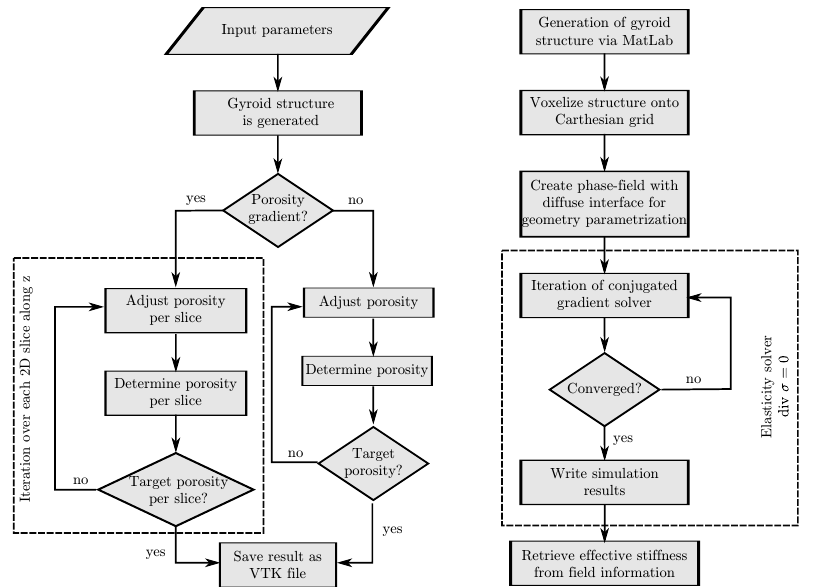
Figure 2. Schematic representation of the computational design of the structures. Generation of the gyroid structures in the MatLab program ( left ) and the workflow for the mechanical simulations with P ACE 3D ( right